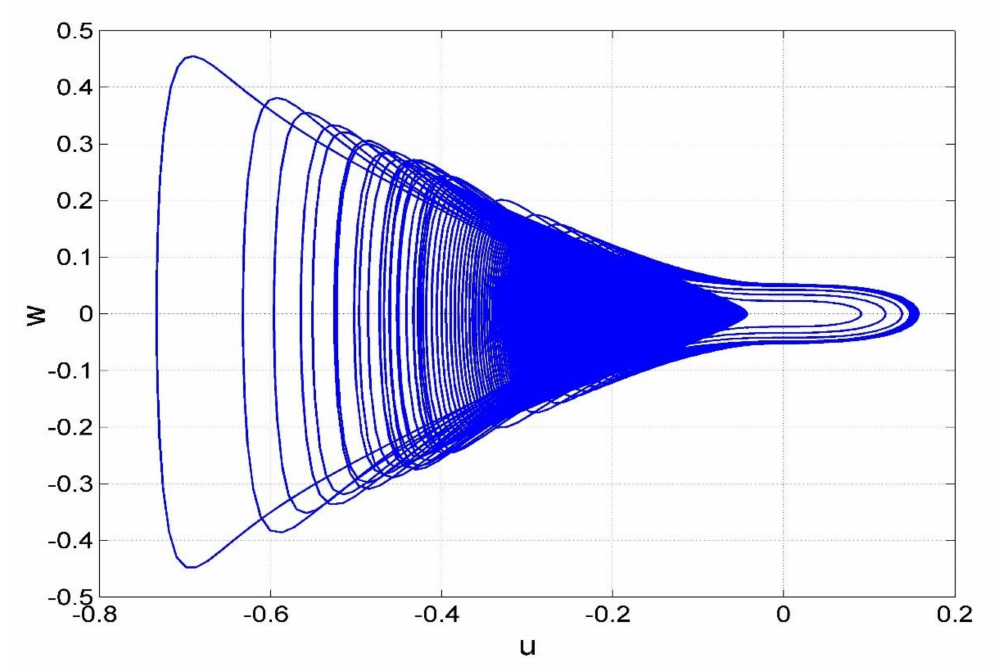
Figure 4. The 2-D signal representation of the chaotic model (4) in the ( u , w ) − plane for the parameters ( a , b , c ) = ( 14,0.5,1.4 ) and the initial state ( u ( 0 ) , v ( 0 ) , w ( 0 )) = ( 0.05,0.05,0.05 ) .